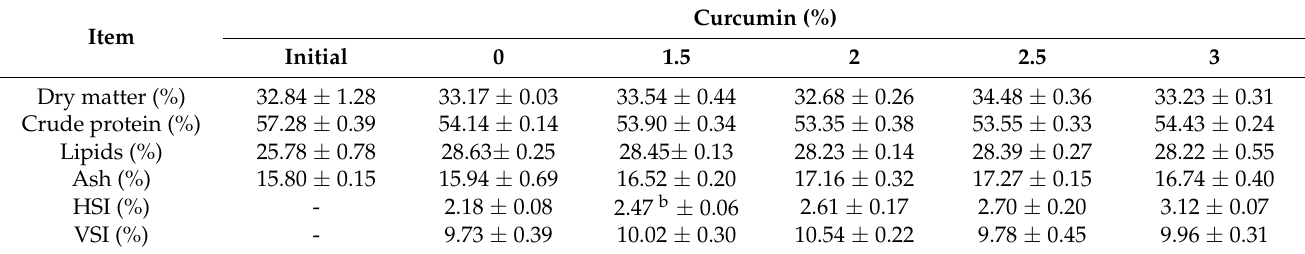
Table 3. Carcass composition and somatic indices of Gilthead seabream fed varying levels of dietary curcumin for 150 days.